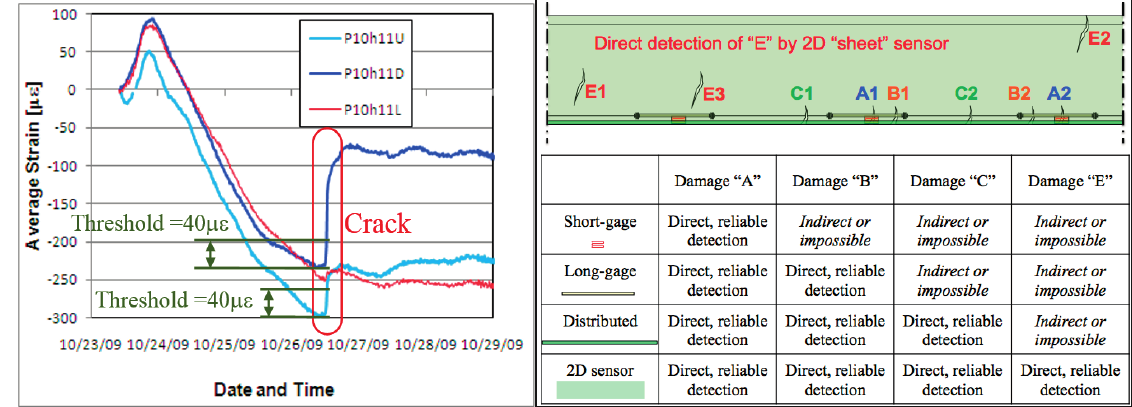
Figure 1. ( Left) : example of direct damage (crack) detection; ( Right ): schematic comparison between damage detection capabilities of short-gauge, long-gauge, and 1D distributed sensors, and the need for 2D sensing sheets, with permission from [3] (figure does not refer to real